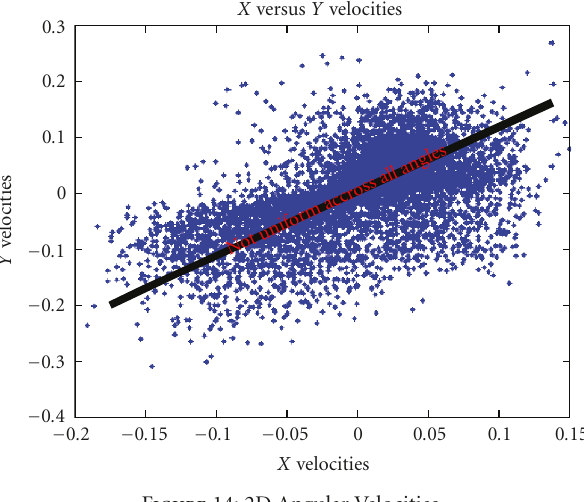
Figure 14: 2D Angular Velocities.